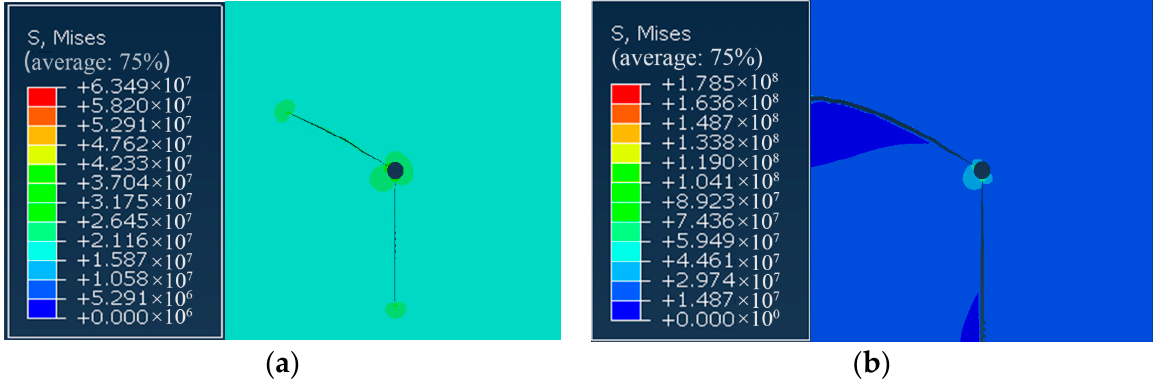
Figure 3. Cloud map of fracture pore pressure distribution. ( a ) Step 674 moment; ( b ) Final moment.